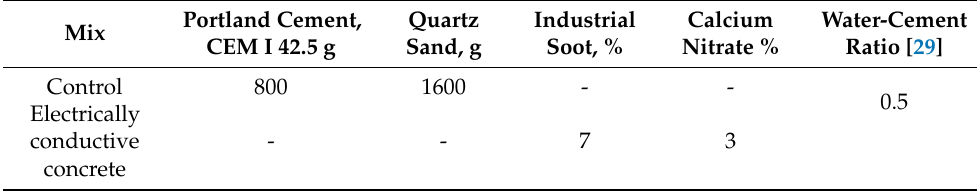
Table 2. Component ratio of